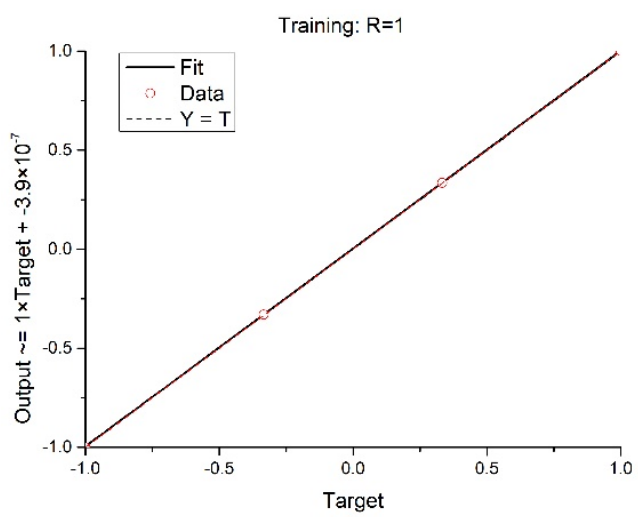
Figure 5. Regression analytical curve.